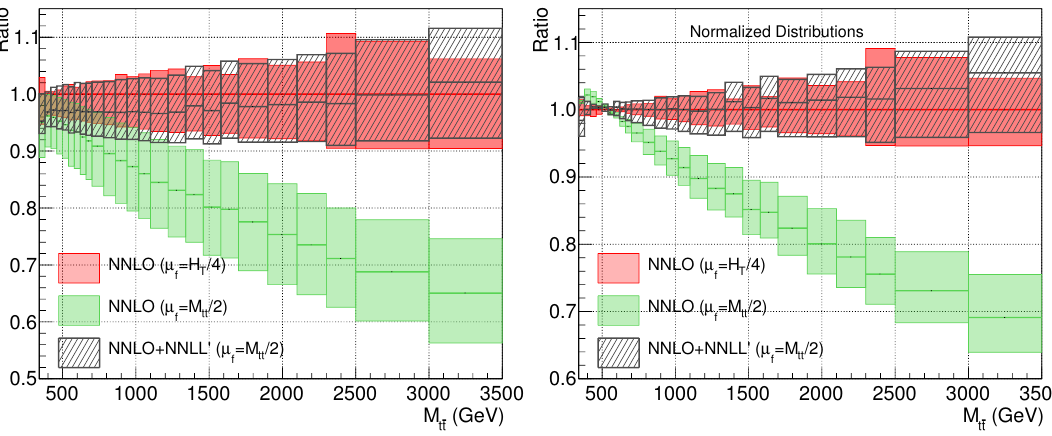
Figure 5 . Results for the absolute (left) and normalized (right) top-pair invariant mass distribution at the LHC with p s = 13 TeV as a ratio to the NNLO result evaluated using (cid:22) f = H T = 4. The uncertainty bands are obtained through scale variations as described at the beginning of section 5 and in eqs. (5.1) and (5.2).